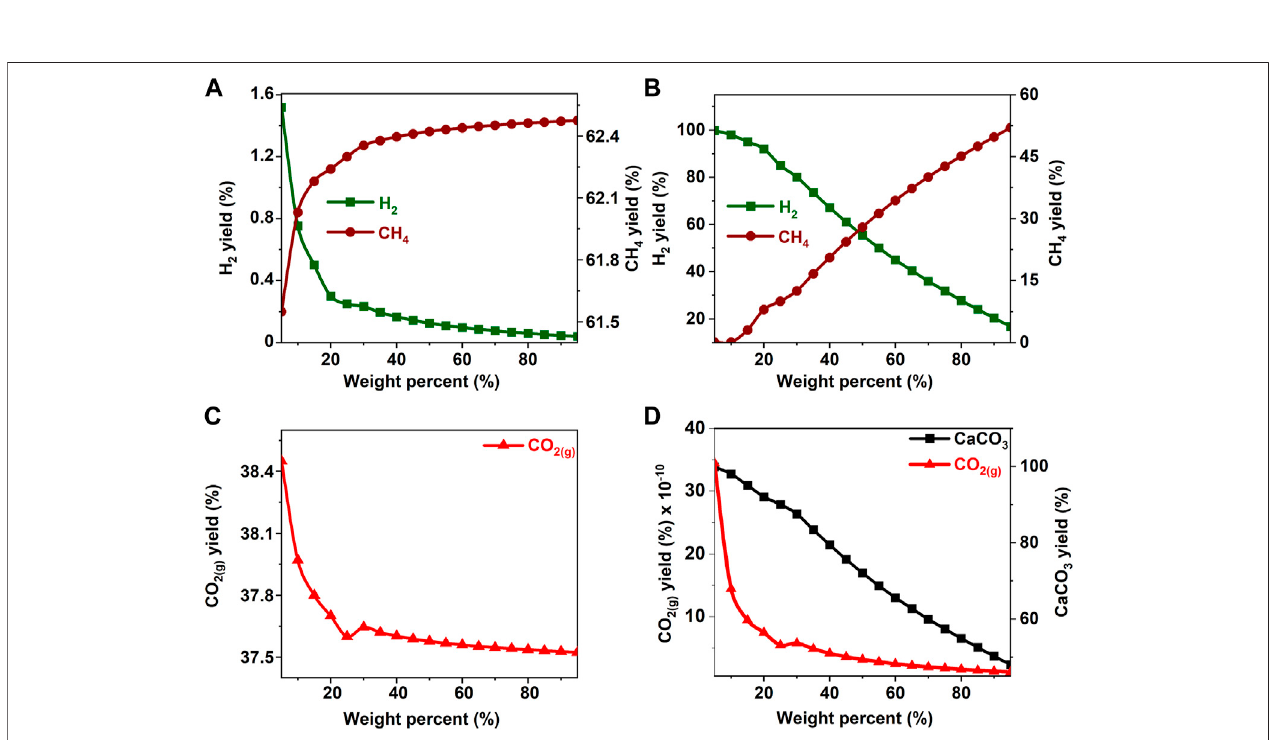
FIGURE6| Effectofethyleneglycolconcentrationontheproductyield (A , C) intheabsenceand (B) inthepresenceofcalciumoxide.TheyieldofCO 2 postcapture to produce calcium carbonate is represented in 4 (D) . These calculations are performed with temperatures of 227 ° C and pressures of 50 bar.